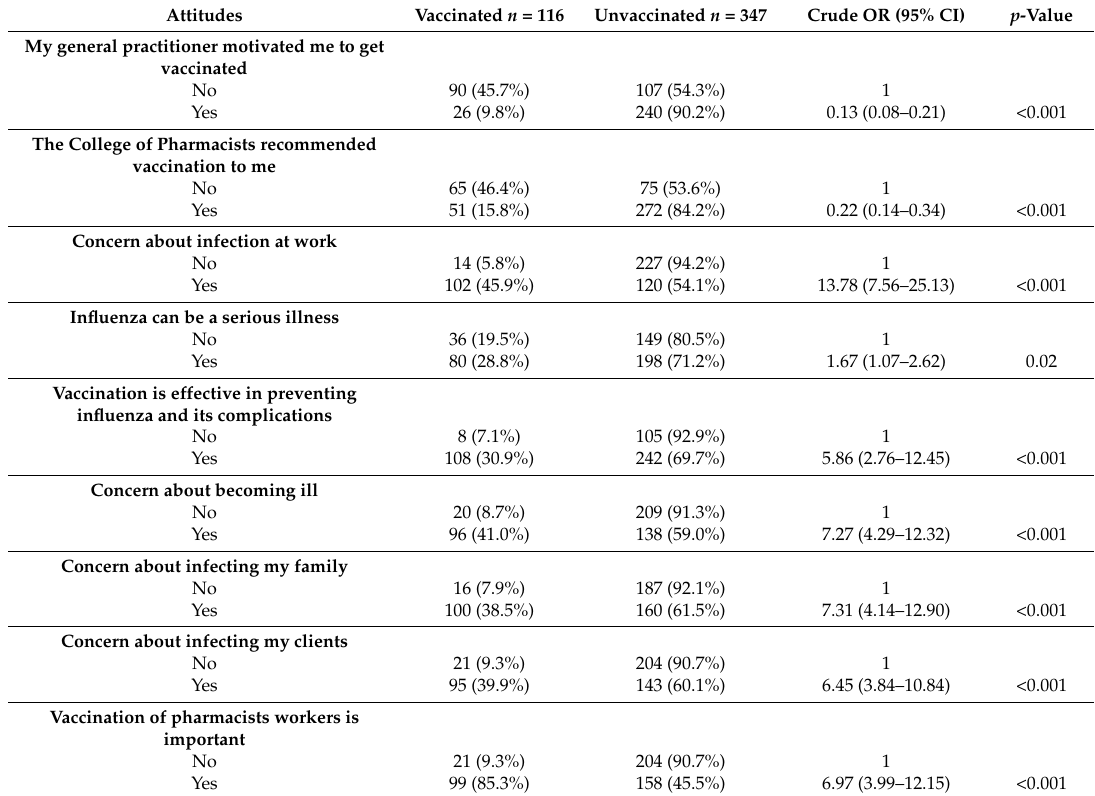
Table 4. Distribution of influenza vaccinated and unvaccinated community pharmacists in the 2013–2014 season according to attitudes towards influenza